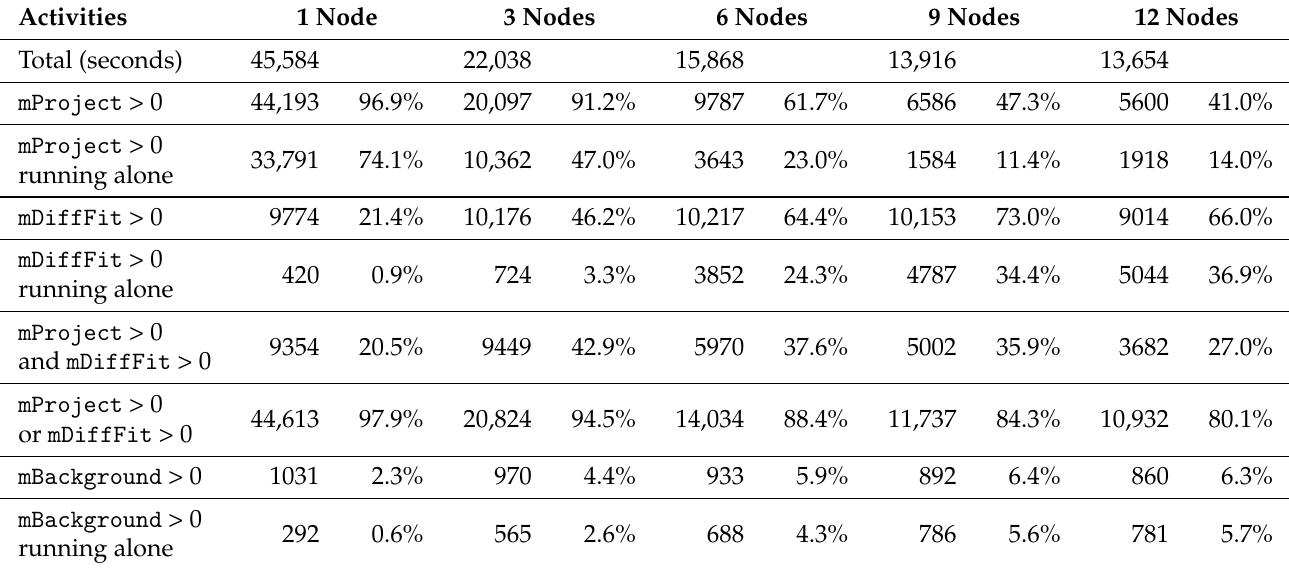
Table 2. Montage jobs and their execution patterns on a 1.5 degree workflow.